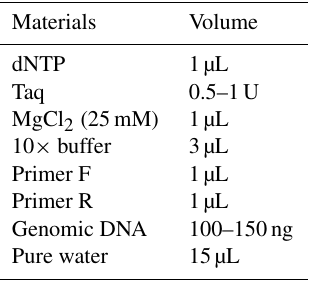
Table 2. PCR components and their respective amounts for the Pit- 1 and CSN3 gene